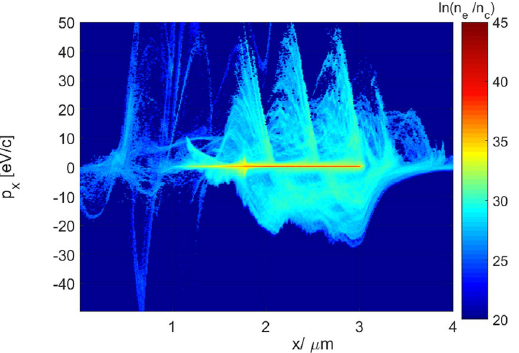
Figure 1. A momentum-position phase space plot in the laser-forward direction demonstrating the high- momentum peaks characteristic of the ZVP mechanism. The laser amplitude, was set to = a 100 electron density was 50 times